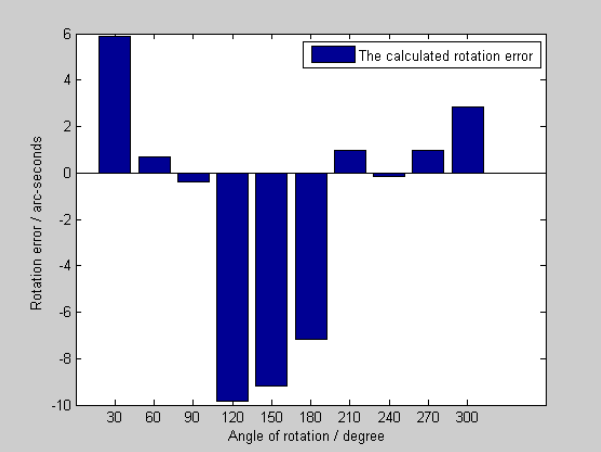
Table 3. Angular positioning deviation of the rotary table obtained by experiments.